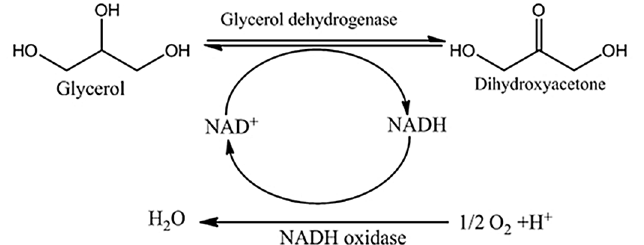
Fig 1. Bioconversion of glycerol by fused glycerol dehydrogenase and NADH oxidase coupled with NADH